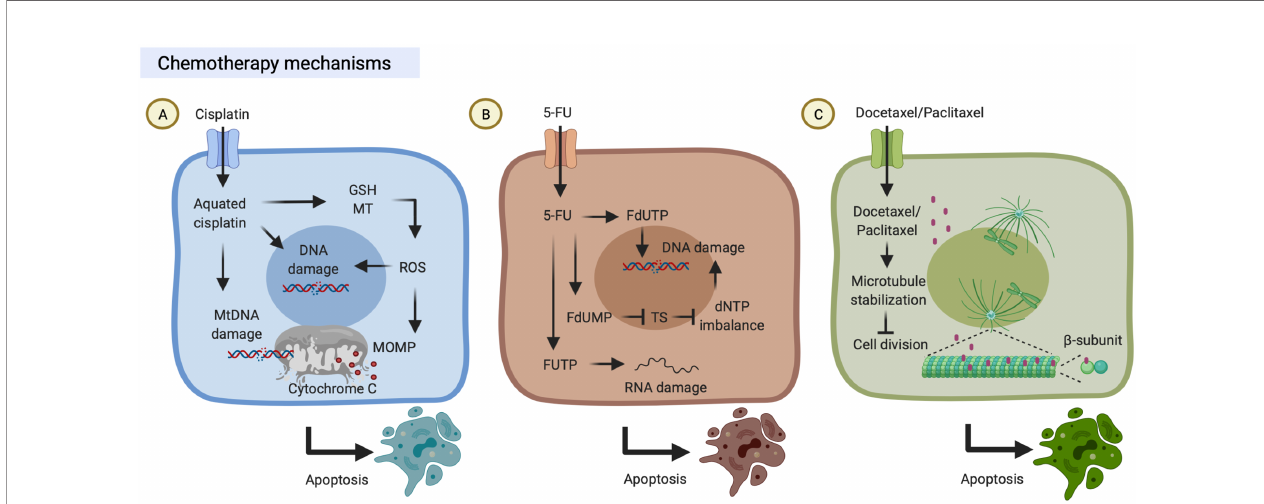
FIGURE 1 | Chemotherapy mechanisms. (A) Cisplatin is transported into cells through copper transporters and is aquated in the cytosol. Aquated cisplatin induces DNA damage by binding to nuclear or mitochondrial DNA. On the other hand, aquated cisplatin also binds to cytoplasmic structures, including reduced glutathione (GSH) and metallothionein (MT), which results in the generation of reactive oxygen species (ROS) that trigger mitochondrial outer membrane permeabilization (MOMP). Both DNA damage and MOMP lead to cell death. (B) 5-Fluorouracil (5-FU) can be transported into cells by uracil transporters due to its uracil-like analog structure. Intracellular 5-FU is converted to three primary active metabolites which result in DNA/RNA damage: (i) fl uorodeoxyuridine monophosphate (FdUMP) inhibits thymidylate synthase (TS); (ii) fl uorodeoxyuridine triphosphate (FdUTP) is misincorporated into DNA; and (iii) fl uorouridine triphosphate (FUTP) is incorporated into RNA. (C) Docetaxel/Paclitaxel can bind to microtubules which promotes tubulin assembly, suppresses microtubule dynamics and cell division, and ultimately results in cell death. These fi gures were created with